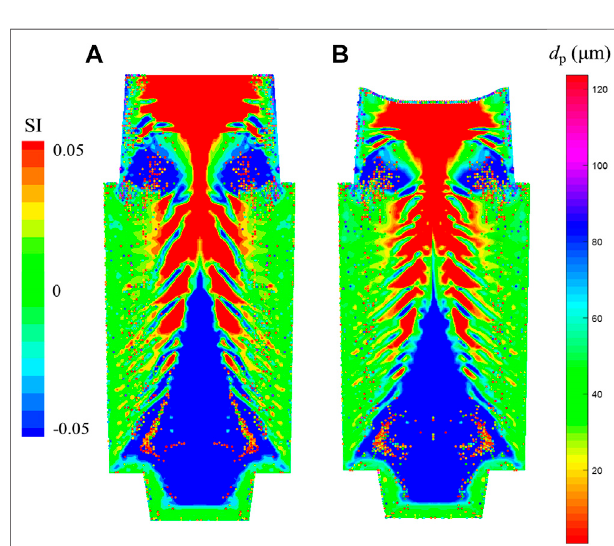
FIGURE 9 | Predicted inclusion and macrosegregation distribution after solidi fi cation: (A) simulation result of the four-phase inclusion model, (B) simulation result of the fi ve-phase model. Inclusion particles are represented by colored dots with different diameters.